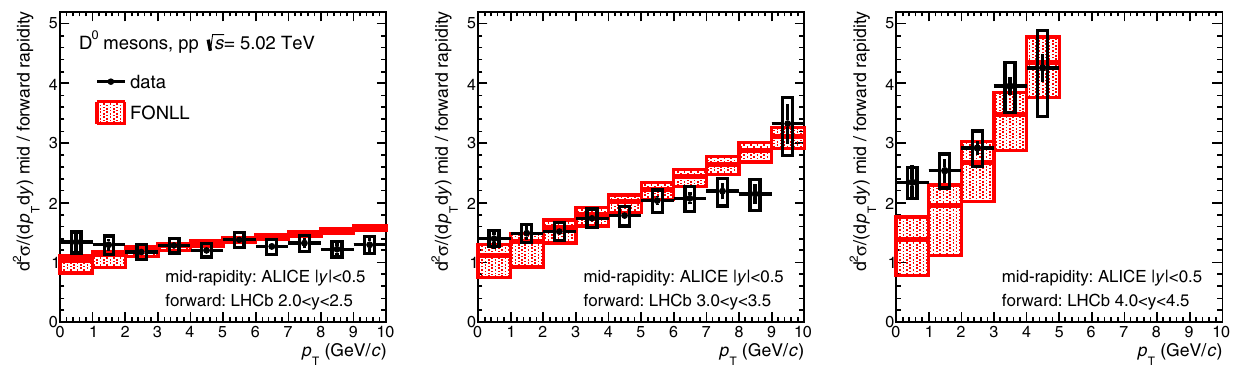
Fig. 14 Ratios of D 0 , D + , D ∗+ and D + s -meson production cross sections in pp collisions at of p T (left panel). D 0 ratio compared to FONLL pQCD calculations [7,8] (right panel)